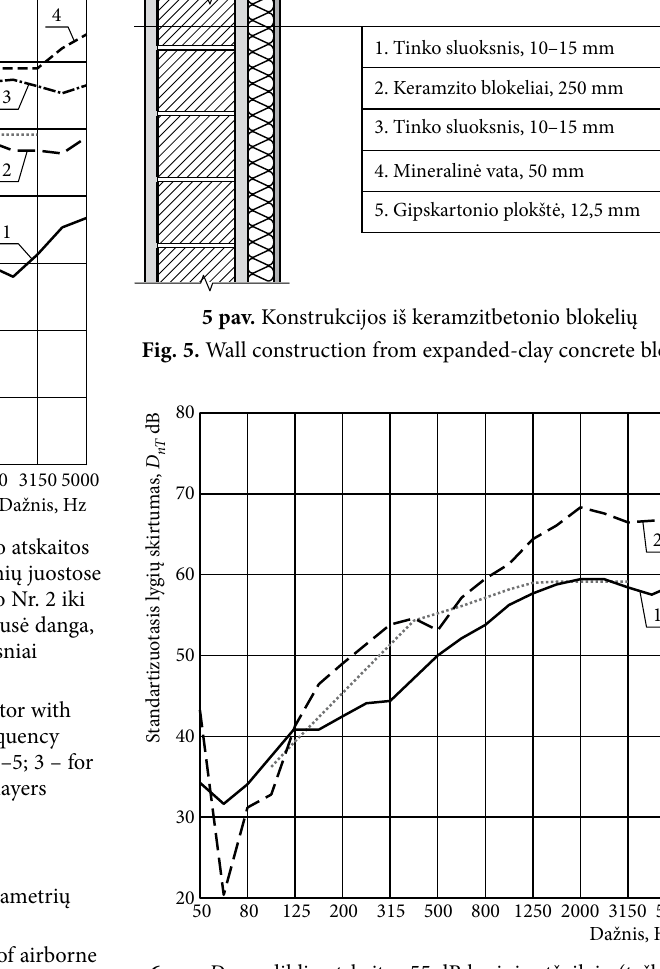
rodiklio atskaitos 55 dB kreivės atžvilgiu (taškinė 6 pav. D nT kreivė) priklausomybė nuo dažnio (5 pav.): 1 – konstrukcijai iš sluoksnių Nr. 1–3 ; 2 – konstrukcijai iš sluoksnių Nr. 1–5 indicator with Fig. 6. The correlation of readings of D nT respect to curve 55 dB (dotted curve) with frequency (see Fig. 5): 1 – for construction from layers No. 1–3; 2 – for construction from layers No. 1–5